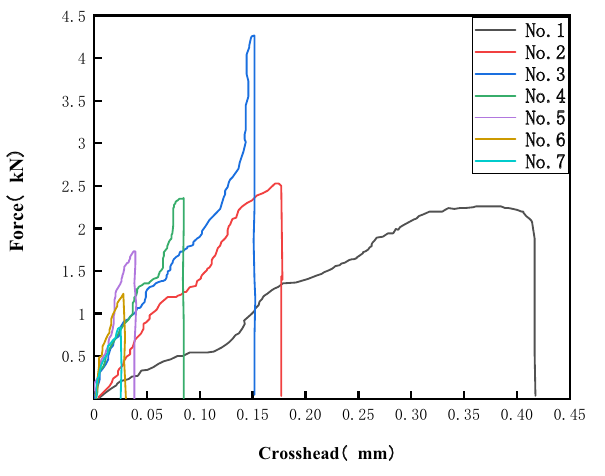
Figure 12. Force elongation curve.